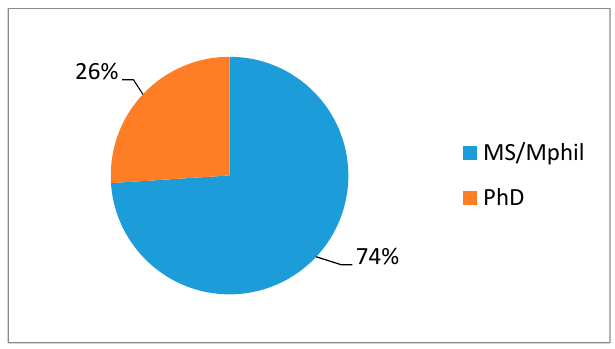
Figure 1. Course-wise participants of this survey. Table 1. LIS schools and percentage of responses.